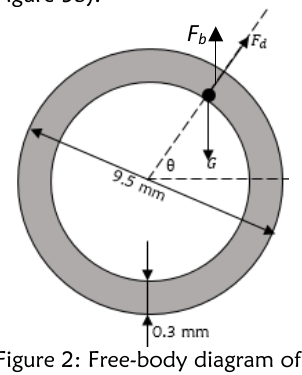
Figure 3 (a) Side view of electrode and workpiece, and (b) enlarged view at the top most position